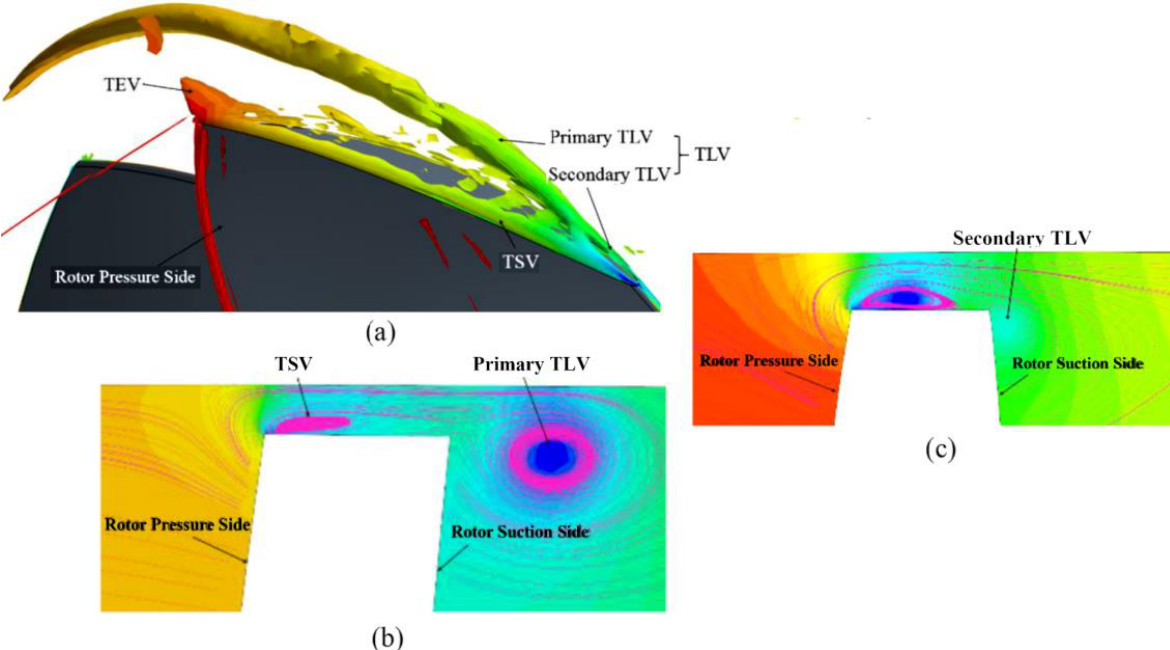
Figure 9. Schematic of common tip-clearance flows [64]. ( a ) tip-clearance flows by iso-surfaces of Qcriterion, ( b ) primary TLV, ( c ) secondary TLV.